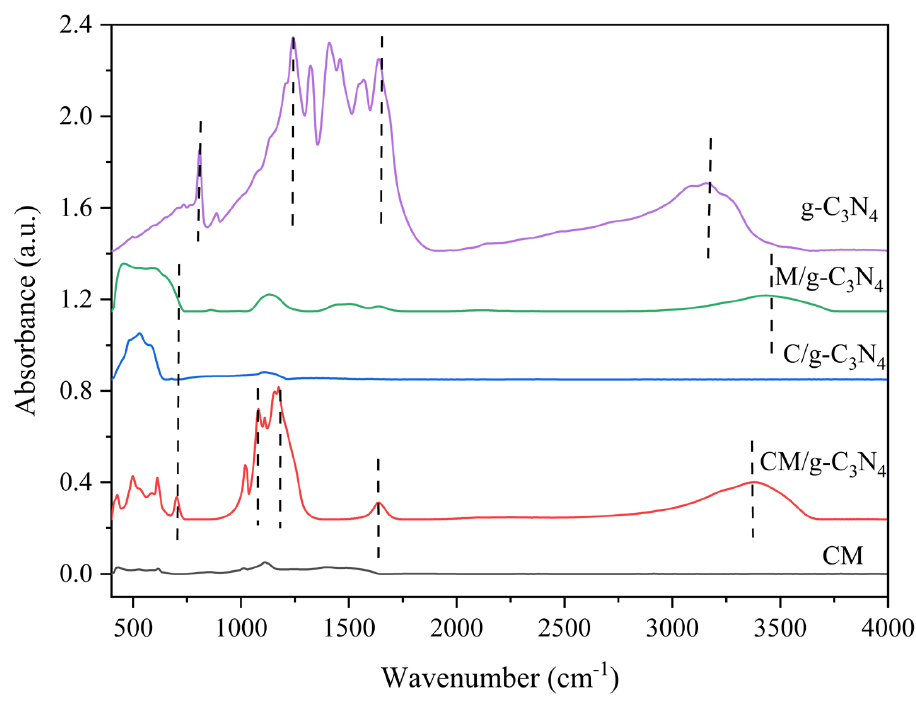
Figure 4. FTIR spectra of different catalysts (g-C 3 N 4 ; M/g-C 3 N 4 ; C/g-C 3 N 4 ; CM/g-C 3 N 4 ;